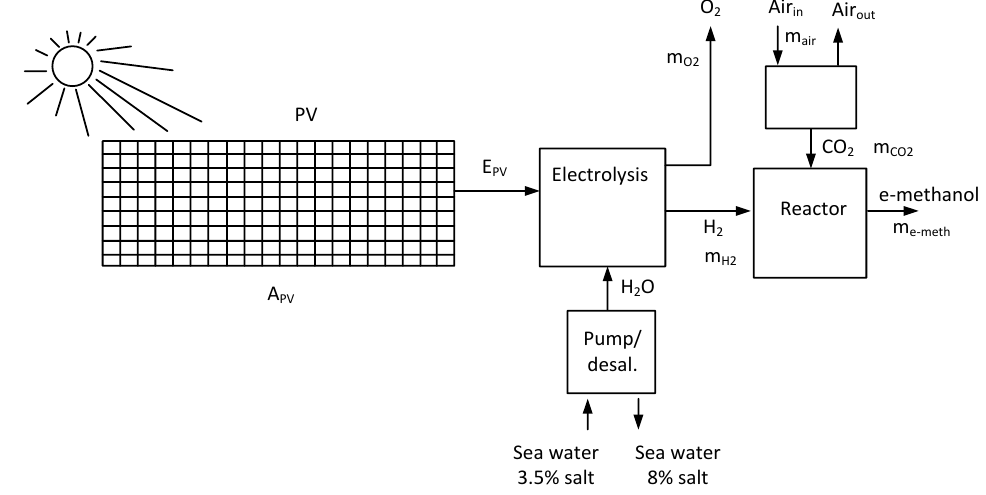
Figure 1. Schematic representation of the e-methanol production process.